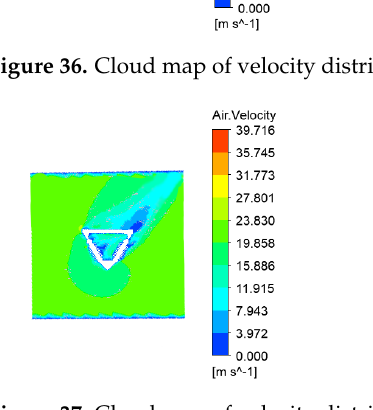
Figure 37. Cloud map of velocity distribution in the plane with 60 ◦ wind elevation angle.